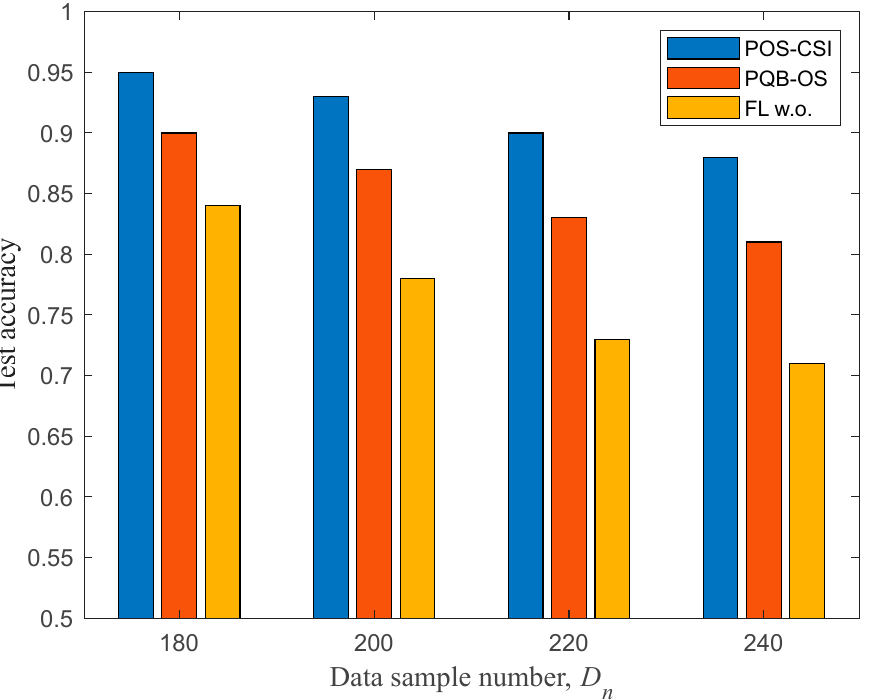
Figure 9. Test accuracy versus data sample number of different schemes with MNIST dataset for